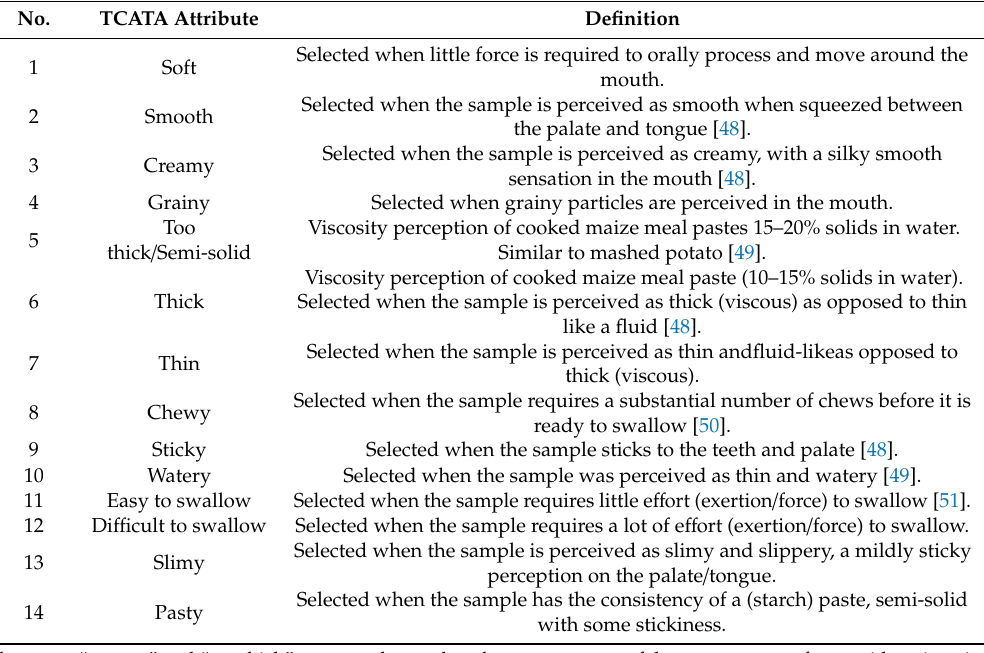
Table 2. Definitions of the in-mouth texture attributes used during the evaluation of complementary porridges (CPs) by a trained Temporal Check-All-That-Apply (TCATA) sensory panel ( n = 10).